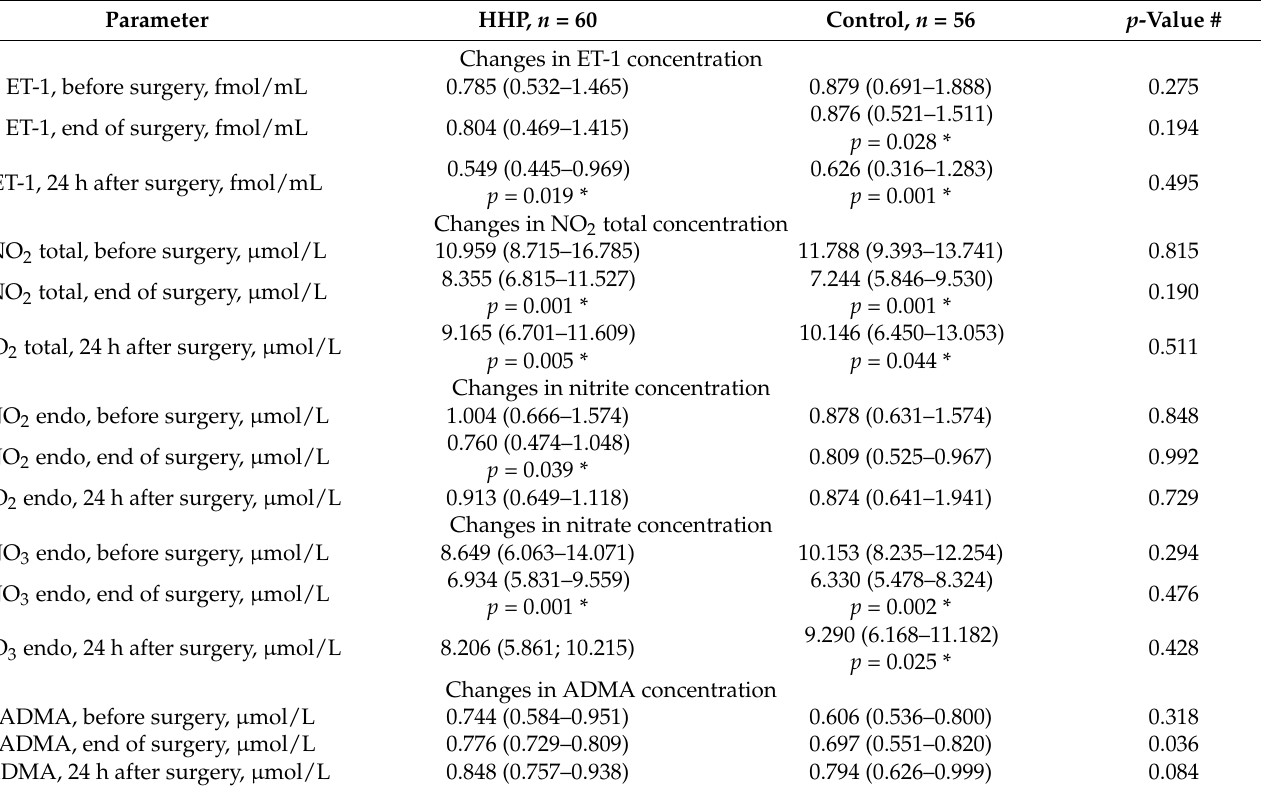
Table 4. Characteristics of endothelin-1, nitric oxide metabolites, and ADMA concentrations in the perioperative period.